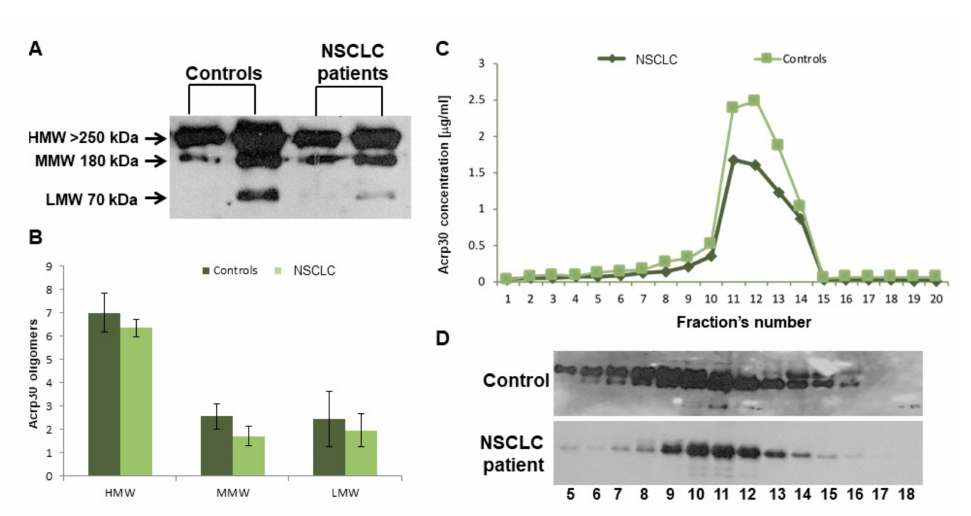
Figure 1. Western Blotting (WB) and FPLC analysis of adiponectin oligomers. ( A ) Western blot of the three Acpr30 oligomers High Molecular Weight (HMW), Medium Molecular Weight (MMW), and Low Molecular Weight (LMW)) in two controls and two lung cancer patients. ( B ) Pixel quantization of adiponectin oligomers of all analyzed controls ( n = 60) and lung cancer patients ( n = 72). ( C ) Each fraction’s aliquot obtained from FPLC analysis was subjected to ELISA. The values are reported as the mean of the absorbance ± SD. ( D ) Western blot analysis of each fraction obtained from FPLC (further details are given in the methods section).